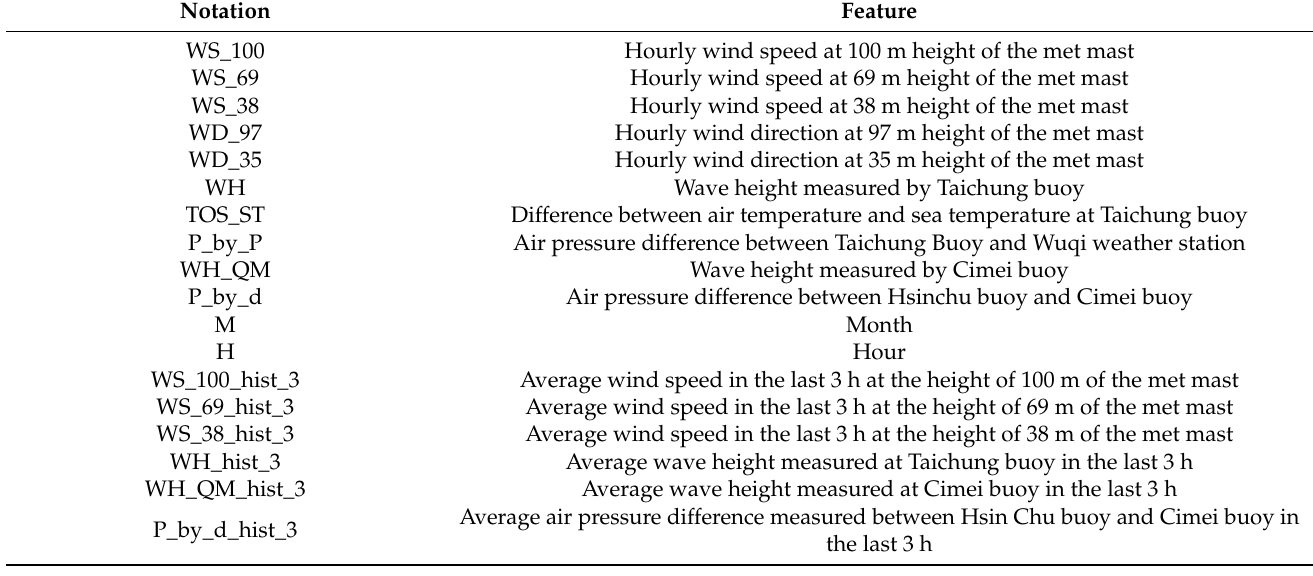
Table 1. The features used and the notation of each feature.